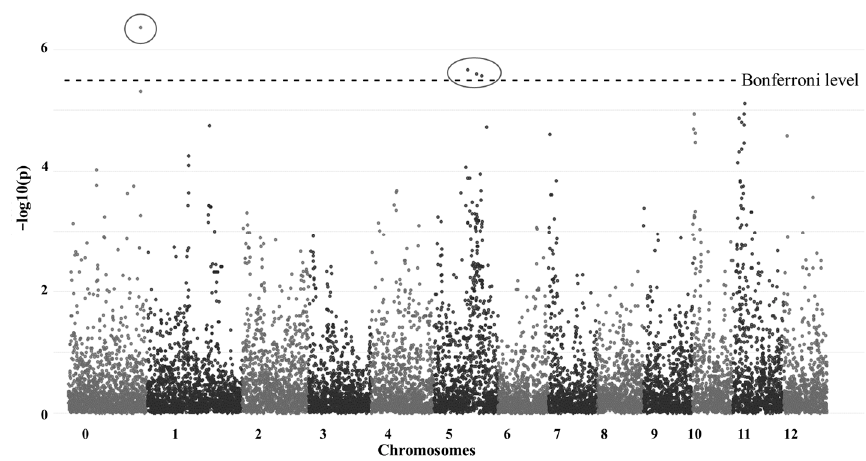
Figure 6. Manhattan plot for − log 10 ( p ) according to meta-analysis data. Ovals encircle four SNPs with − log 10 ( p ) overcoming Bonferroni level.